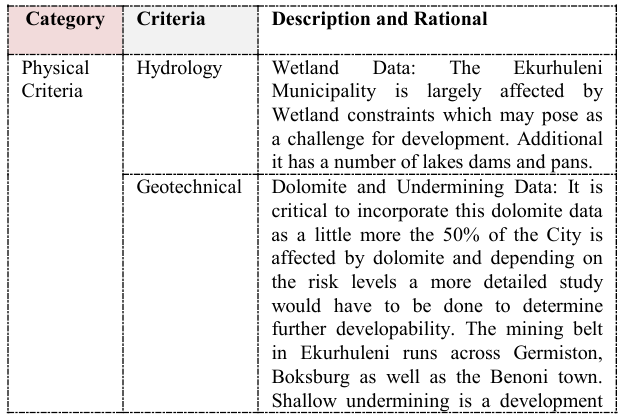
Table 1: Criteria to Identify Strategic location for urban